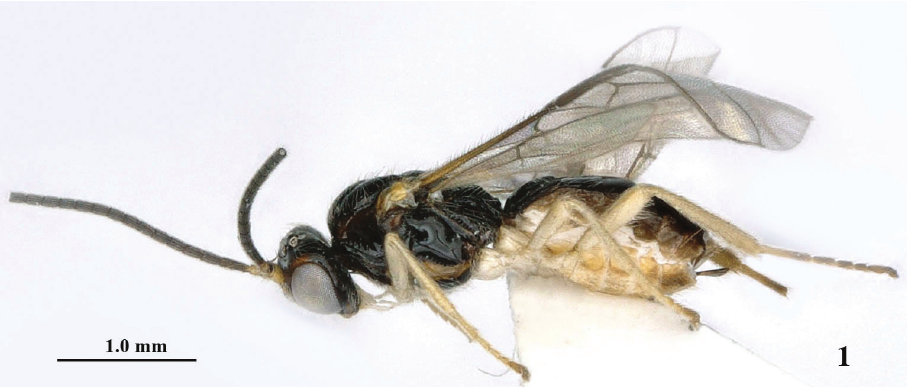
Figure 1. Rhogadopsis aciculifera sp. n., female, holotype, habitus lateral.